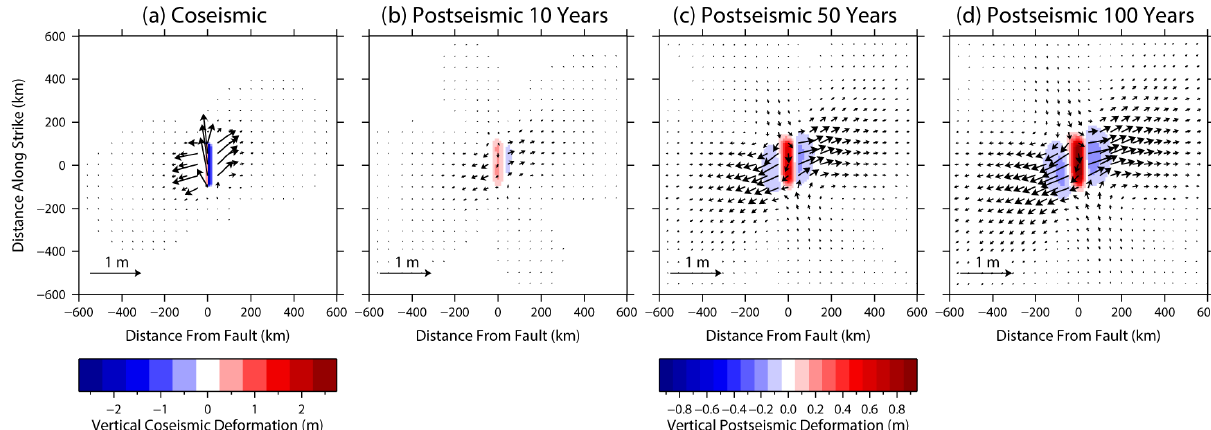
Figure B4. As for Fig. B3, a 45 ◦ dipping fault, but using the PREM Earth model. Note the different colour scales for coseismic and post- seismic